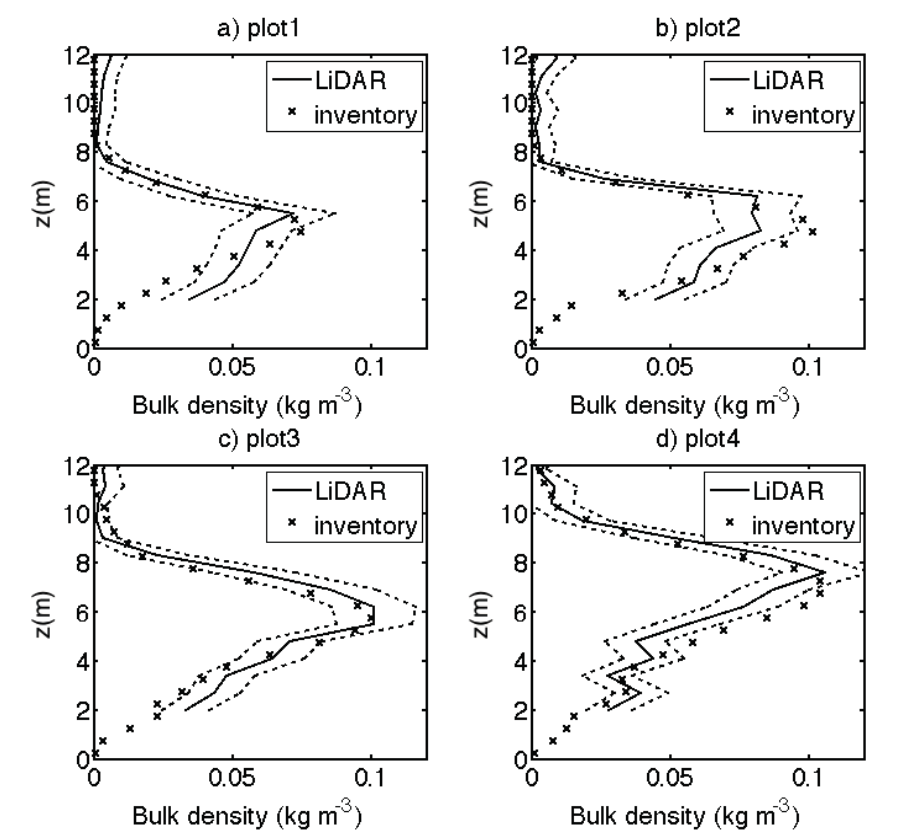
Figure 9. Leaf bulk density profiles estimated from I 3 with their confidence intervals (dashed lines) and inventory-based methods: ( a ) Plot 1; ( b ) Plot 2; ( c ) Plot 3 and ( d ) Plot 4.